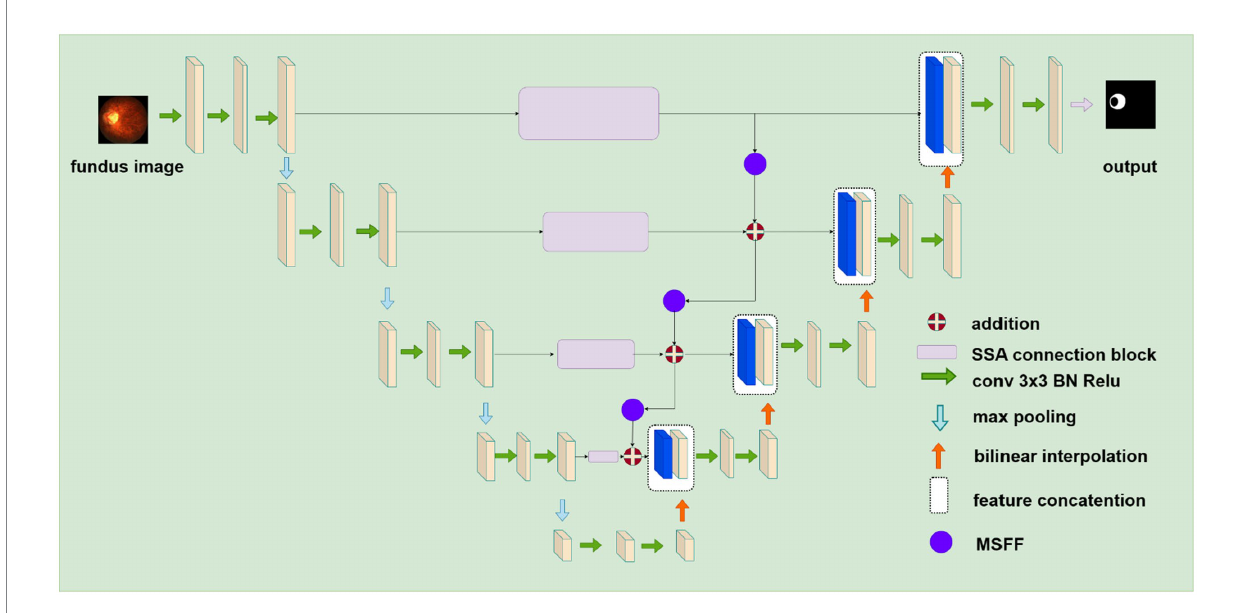
FIGURE 2 The structure of the proposed deep learning network for segmenting retinal atrophic areas from 2D fundus images. The encoder on the left extracts features, and the decoder on the right recovers image details. The SSA connection block represented by purple rectangular flows the feature from the encoder to the